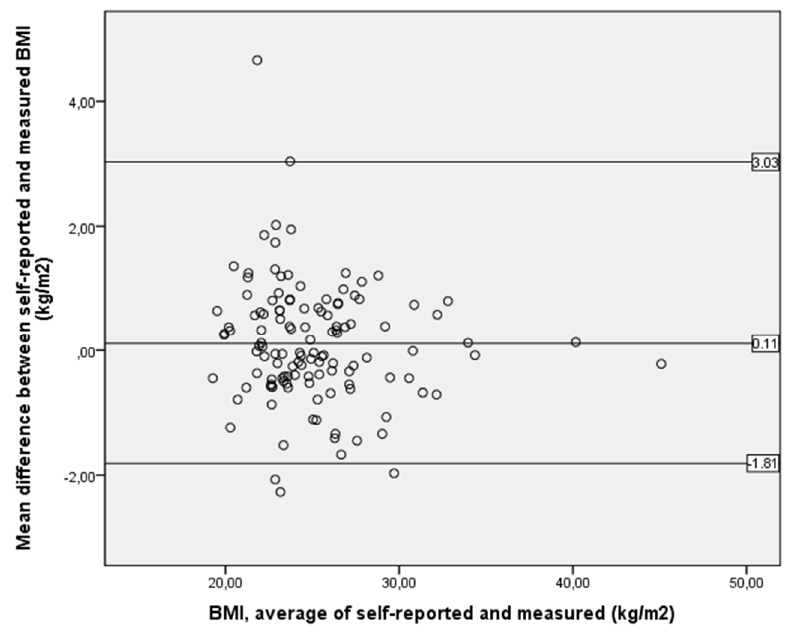
Figure 1. Bland–Altman plot for self-reported and measured BMI (kg/m 2 ). Middle line represents mean difference of methods. Lines above and below represent 95% limits of agreements (LOA), where upper LOA is +1.96 SD and lower line is − 1.96 SD from overall mean difference.